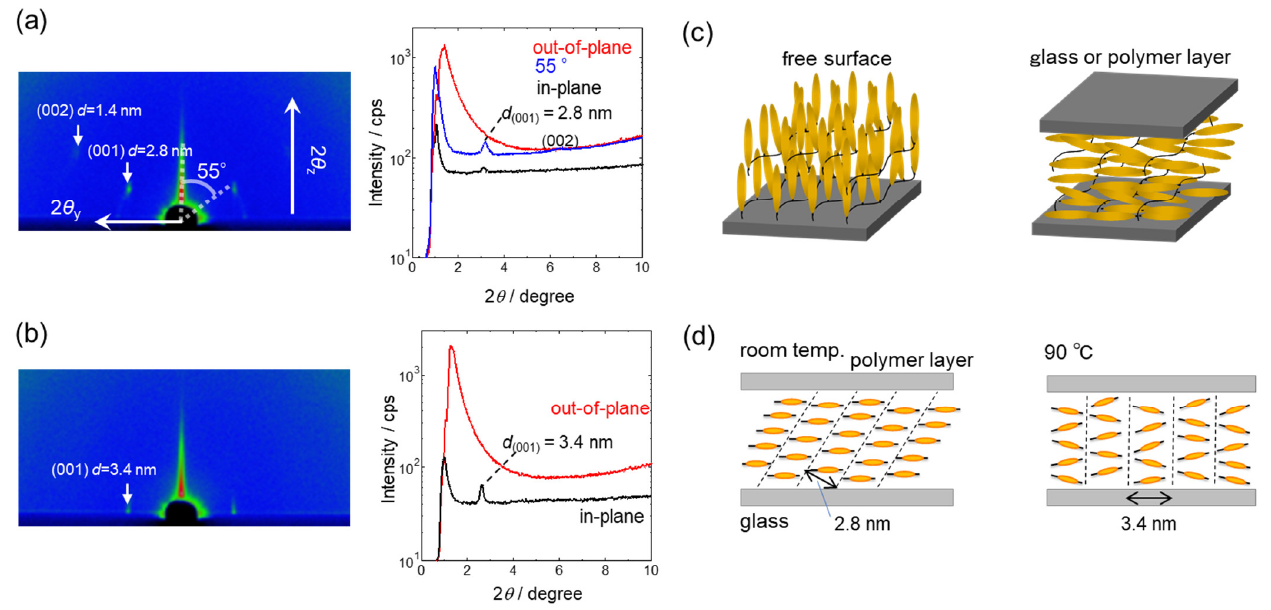
Figure 4. GI-SAXS data for PAz film (thickness: 100 nm) covered with PVP (thickness: 100 nm) at room temperature ( a ) and 90 °C ( b ). In each part, left and right figures display 2D GI-SAXS patterns and 1D intensity profiles taken from the 2D data, respectively. In the left profiles, red, black and blue lines show the out-of-plane and in-plane directions and 55° to the normal direction, respectively. ( c ) Schematics on the mesogen orientation induced by the free surface (left) and glass plate or polymer coat on the top (right) are displayed. ( d ) Schematic illustrations of the structure and orientation of the smectic C phase at room temperature (left) and vertically oriented smectic A phase at 90 °C (right) of PAz film covered with a polymer layer.